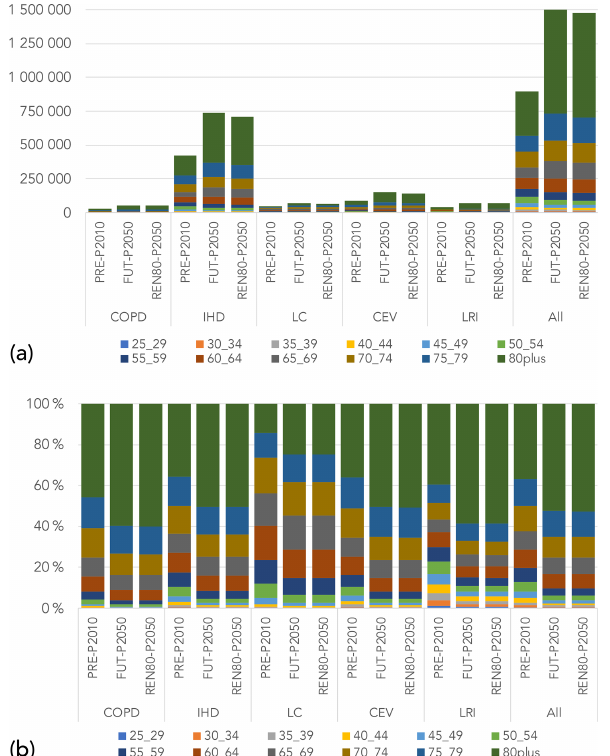
Figure 14. Present (PRE-P2010) and future (FUT-P2010/P2050) estimations of PD per pathology and age group over Europe: (a) to- tal PD per year; (b) %.